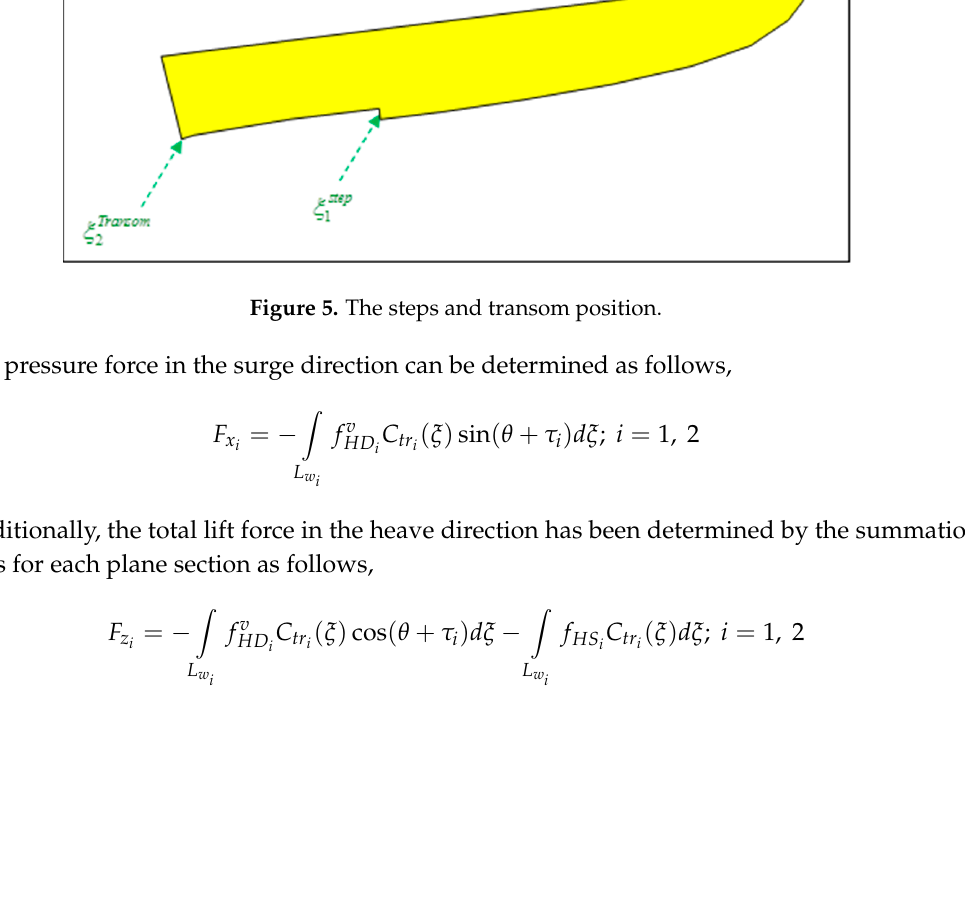
Figure 4. The hydrostatic force acting on the section.